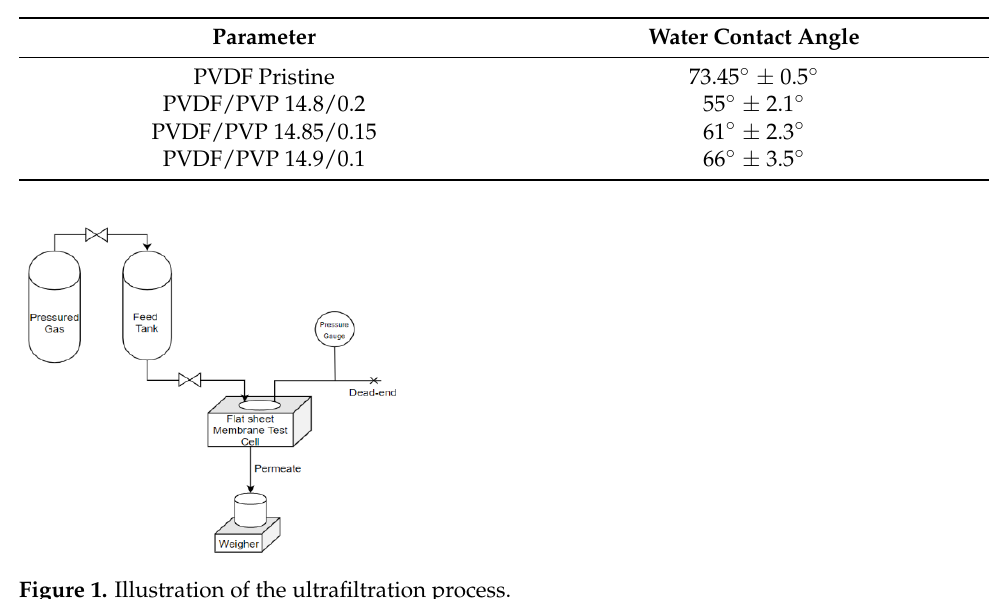
Table 2. Water contact angle of PVDF with various additions of PVP.